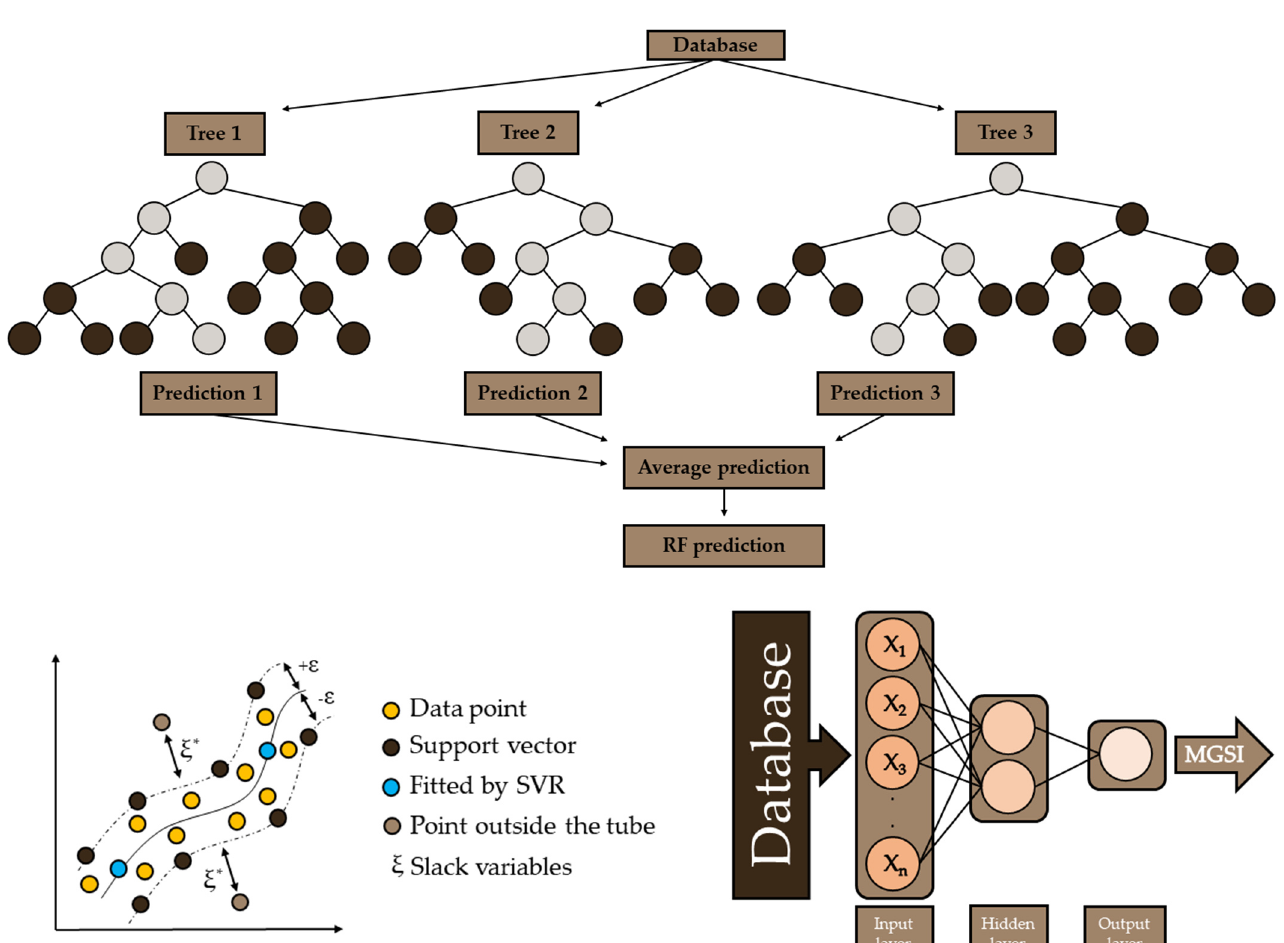
Figure 1. ( top ): scheme of a random forest (RF inspired on Karijadi & Chou (2022) [42]; ( left ): a support vector regression (SVR inspired on Taghizadeh-Mehrjardi et al. (2017) [43]); ( right ): an artificial neural network (ANN inspired on Moldes et al. (2016)